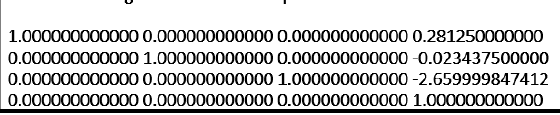
Figure 3. The 4x4 transformation matrix for the applied translation process for MBBC registration method